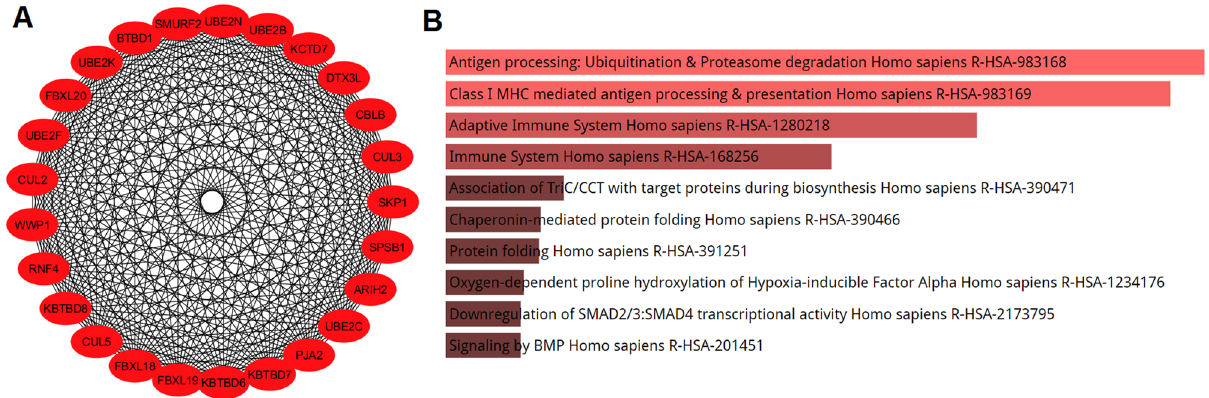
Figure 4. Hub genes in the PPI network could be targeted by enoxacin-induced miRNAs. ( A ) Twenty-five hub genes were identified by Cytohubba and MCC method. ( B ) The KEGG pathway enrichment analysis showed that these genes were mostly associated with MHC class I-mediated antigen processing (p-value = 1.698e−86). The lighter the red color is, the more significant the p-value.